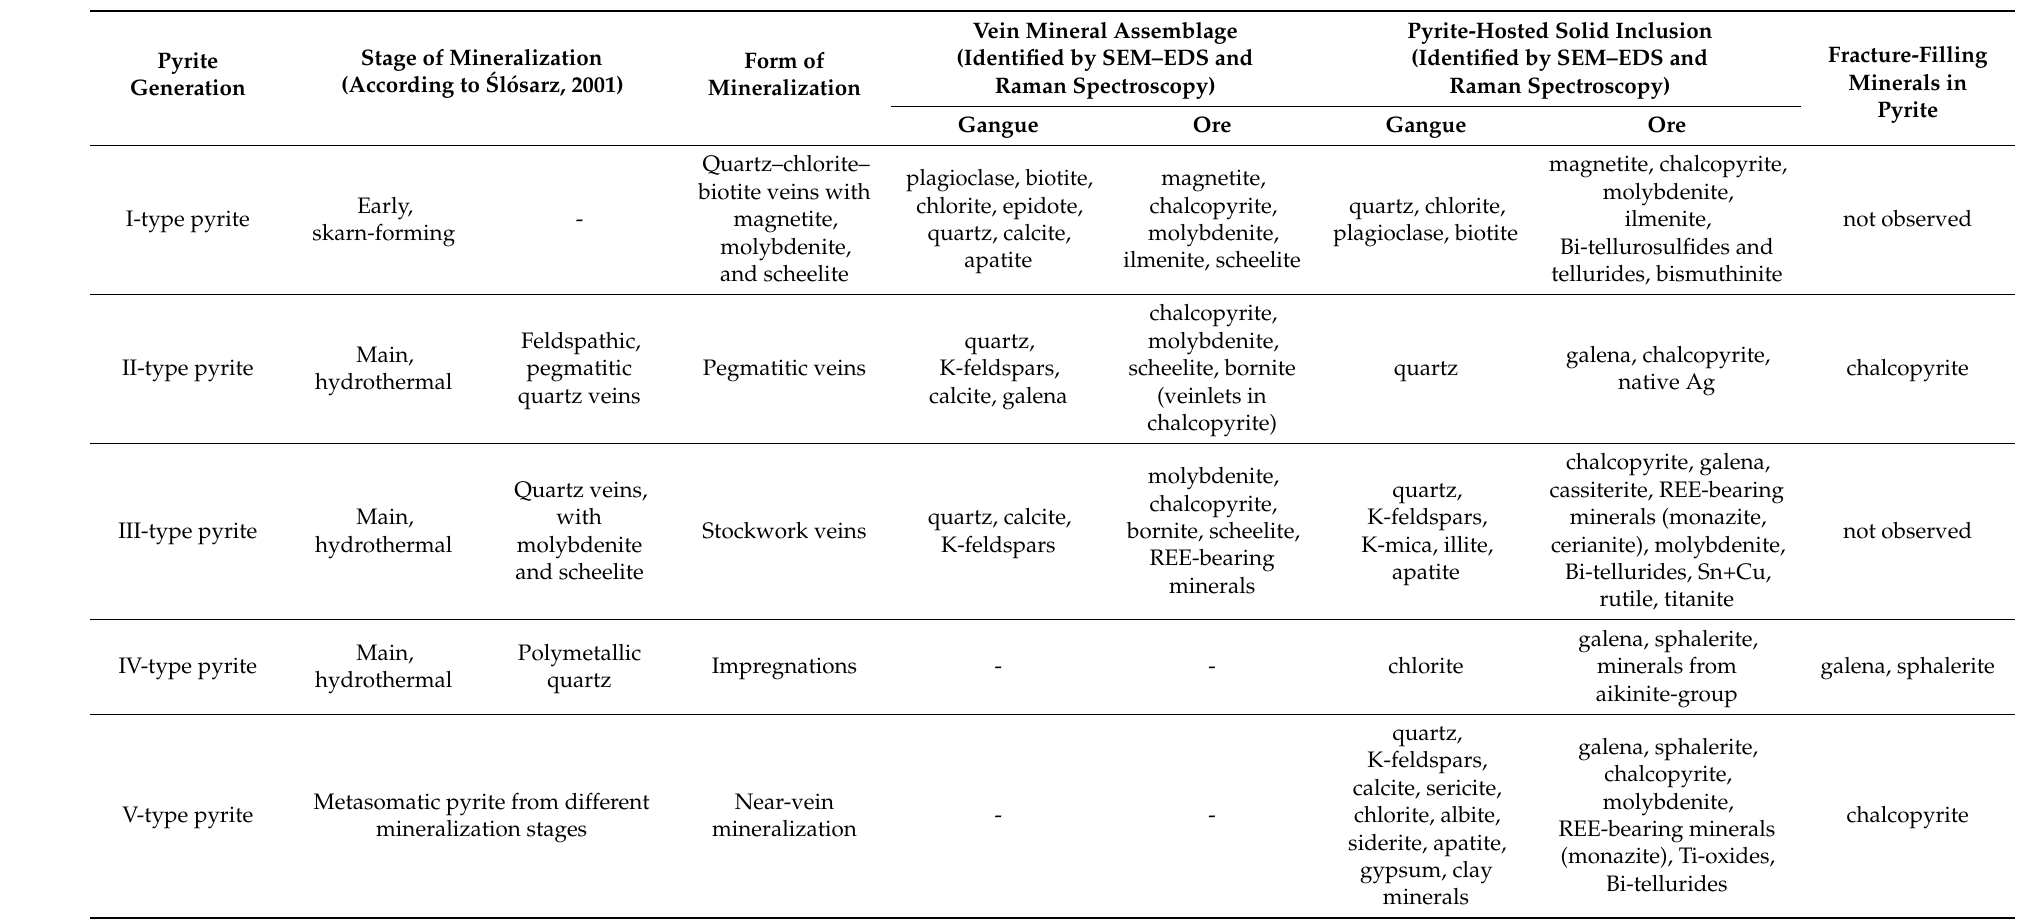
Table 1. Pyrite generations and their